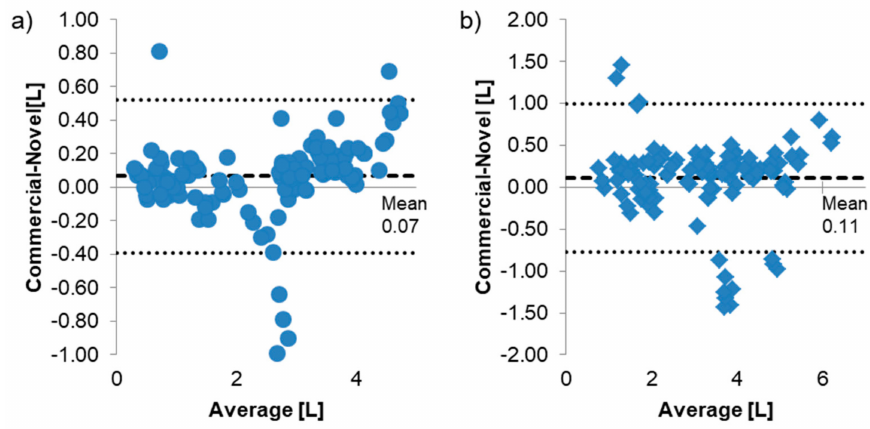
Figure 6. Bland-Altman Plots for ( a ) FEV1, ( b ) FVC. The dashed line indicates the mean and dotted lines indicate the 95% limits of agreement (mean ± 1.96 standard